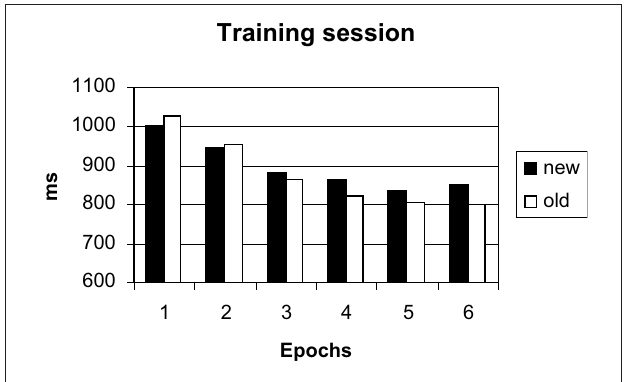
FIGURE 2 | Search times in the training session.